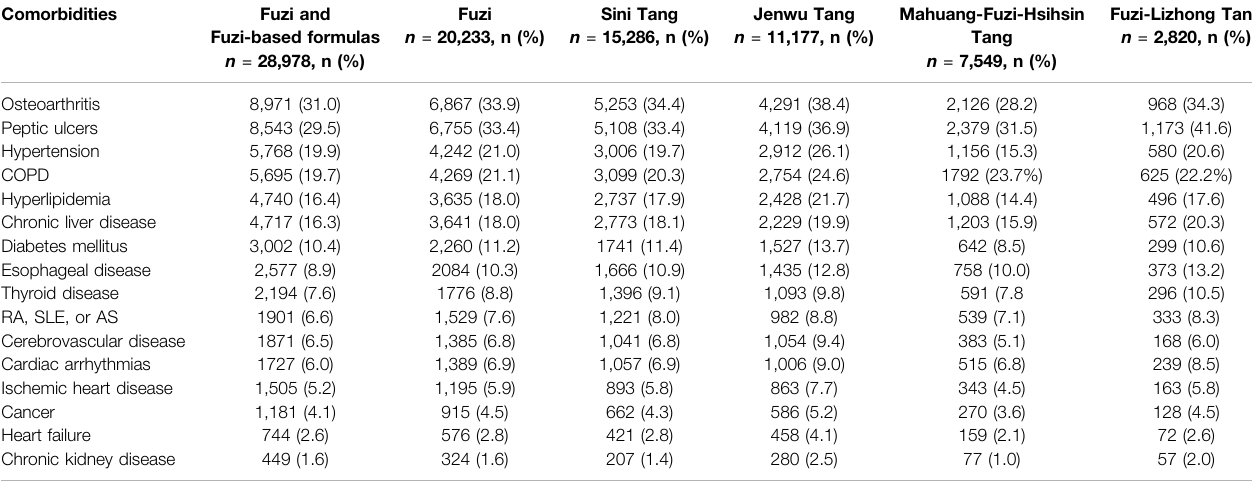
TABLE 2 | Underlying comorbidities diagnosed by Western medicine doctors of patients who long-term used fuzi and fuzi-based formulas. Comorbidities